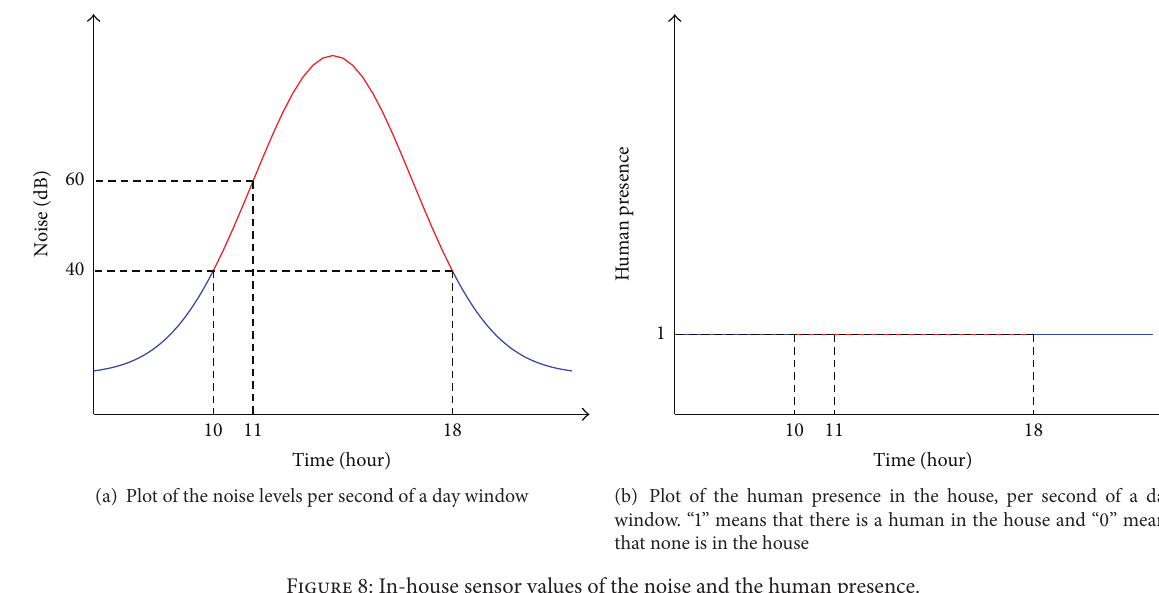
that none is in the house Figure 8: In-house sensor values of the noise and the human presence.